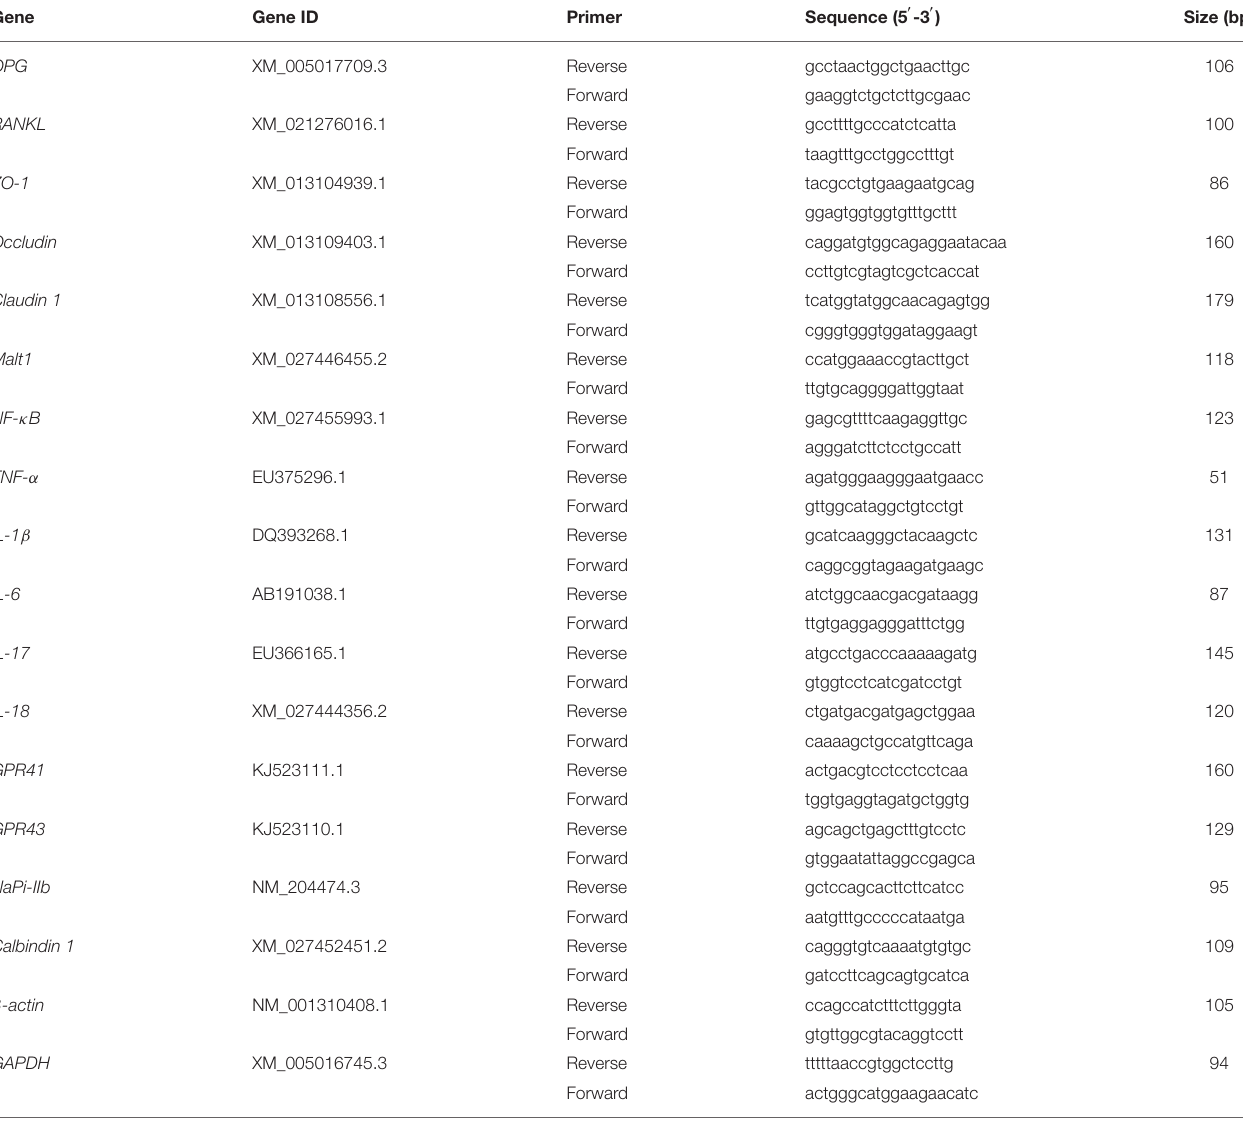
TABLE 2 | The primers for quantitative real-time PCR.